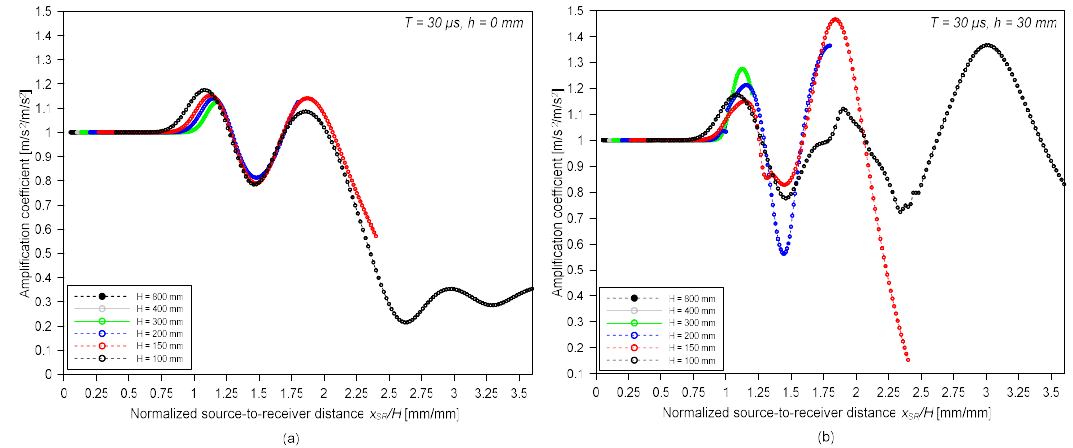
Figure 6. Variation of amplification coefficient of vertical acceleration components of surface waves, α , with respect to normalized source-to-receiver distance, x SR / H : ( a ) from the crack-free FE models, and ( b ) the cracked FE models ( h = 30 mm) with various plate thicknesses—100, 150, 200, 300, 400, and 800 mm.